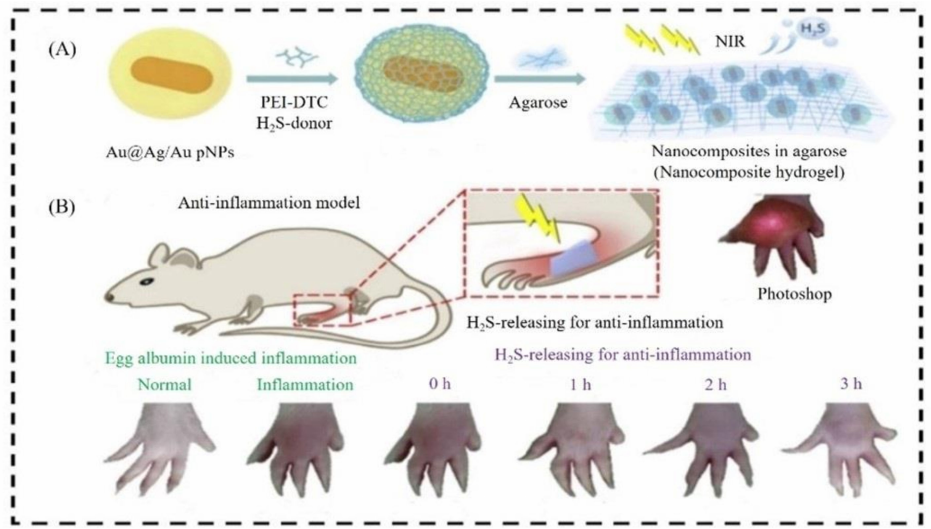
Figure 3. Assessment of anti-inflammation of nano-hydrogel in the systemic circulation. ( A ) Illus- tration of designing nanocomposite hydrogel ( B ) Rat toes in different conditions in a different time interval. Adapted with permission from Ref. [80]. 2020,